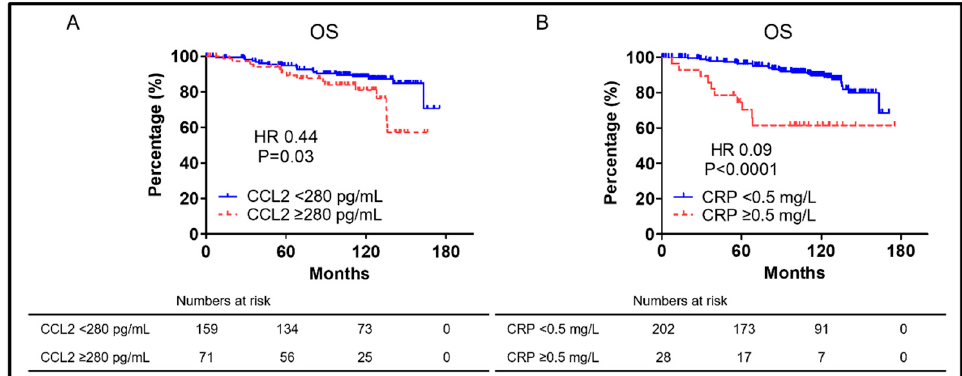
Figure 2. ( A ) Kaplan–Meier curves of OS in nmCSPC with CCL2 ≥ 280 pg/mL and CCL2 < 280 pg/mL. ( B ) Kaplan–Meier curves of OS in nmCSPC with CRP ≥ 0.5 mg/L and CRP < 0.5 mg/L. Numbers at risk for each group are shown at the bottom of the figure. OS, overall survival; CRP, C-reactive protein; HR, hazard ratio; and nmCSPC, non-metastatic castration-sensitive prostate cancer.